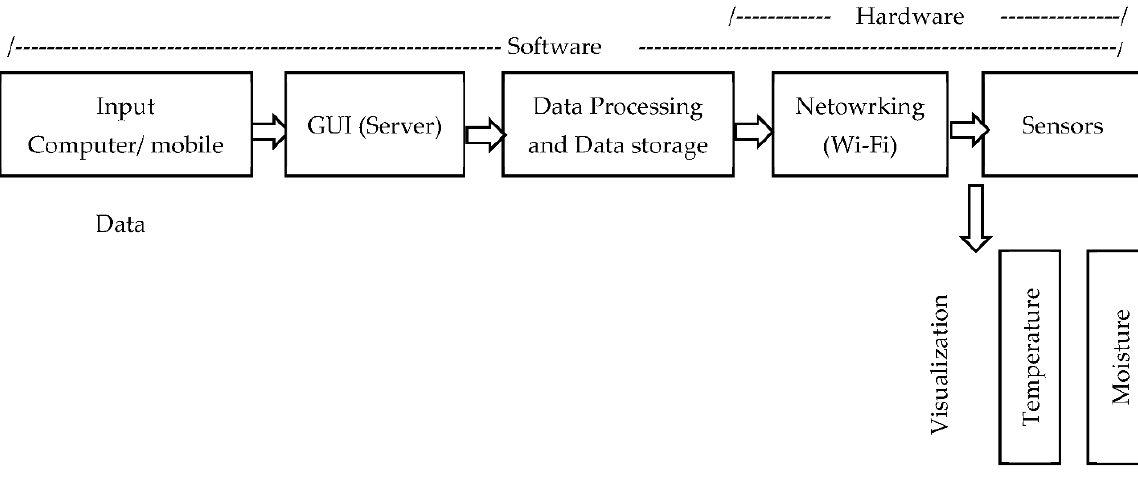
Figure 1. Block diagram of the IoT-based irrigation system.